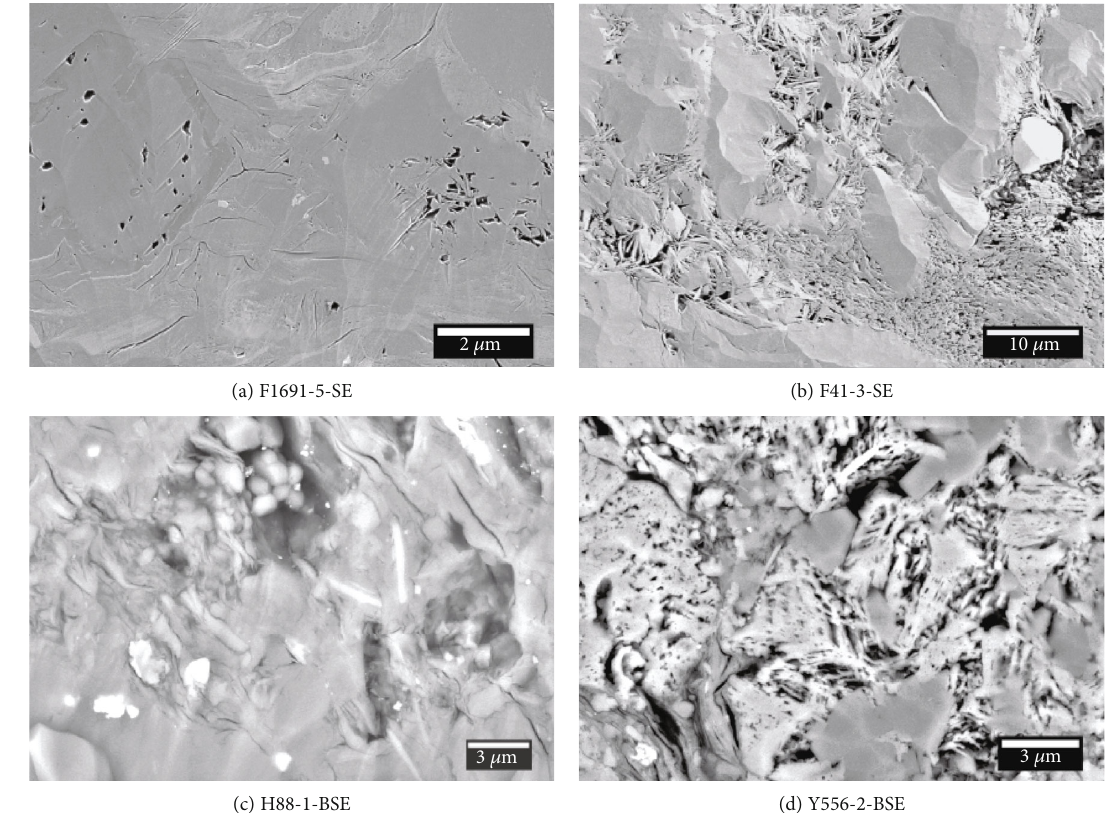
Figure 4: SEM images of the studied